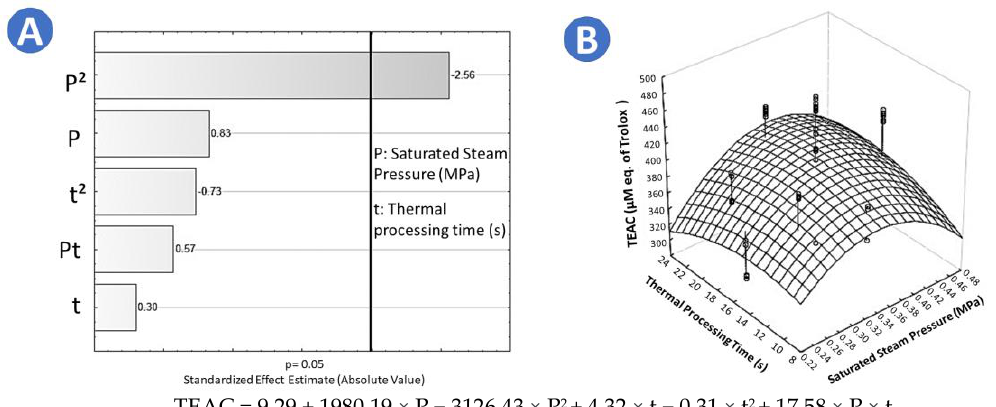
Figure 6. Effects of steam pressure (MPa) and thermal processing time (s) on the Trolox equivalent antioxidant capacity (TEAC) of swell-dried chokecherries. ( A ) Pareto chart and ( B ) surface response plot.